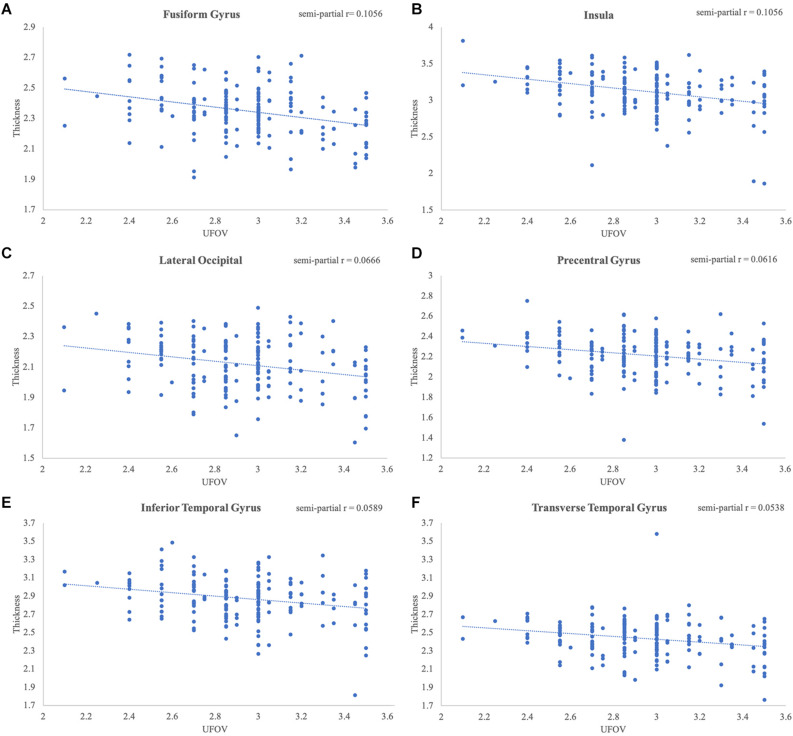
Significant relationships between Double Decision scores and cortical thickness. Scatterplots represent the relationship at the most significant vertex within the (A) fusiform gyrus, (B) insula, (C) lateral occipital gyrus, (D) precentral gyrus, (E) inferior temporal gyrus and (F) transverse temporal gyrus, controlling for education, sex and scanner covariates.